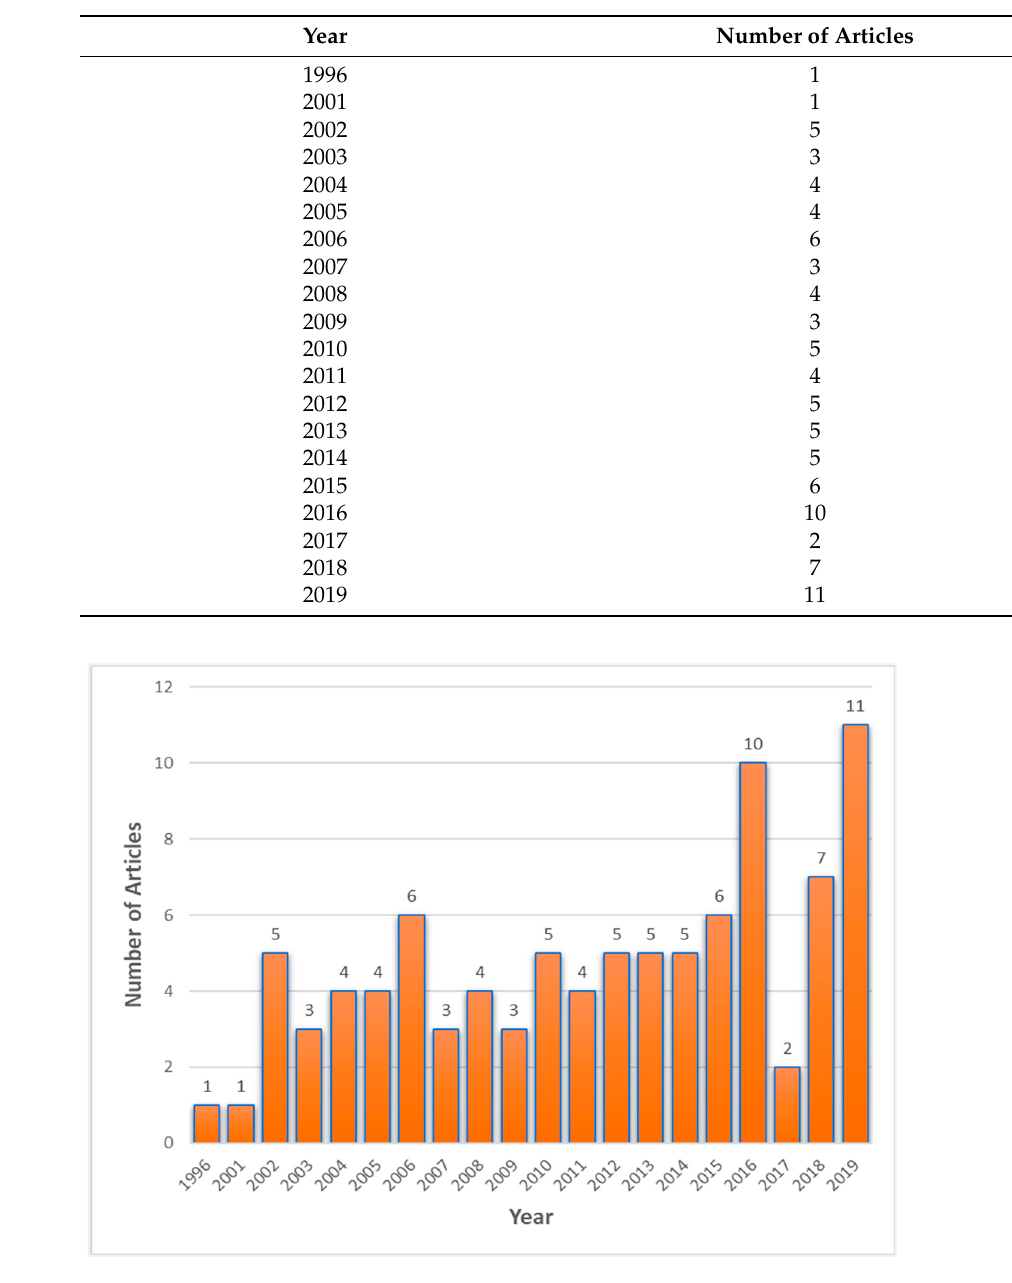
Figure 2. Distribution of articles by years.